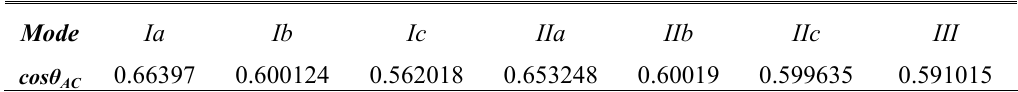
Table 6: The variation of the cosines of the anion-cationic correlation angle in vectorial space, according with the Eq. (15), for all considered modes of action of the ionic liquids of Figure 2 with the cationic and anionic subsystems S-SAR activities given in Tables 3 and 4,